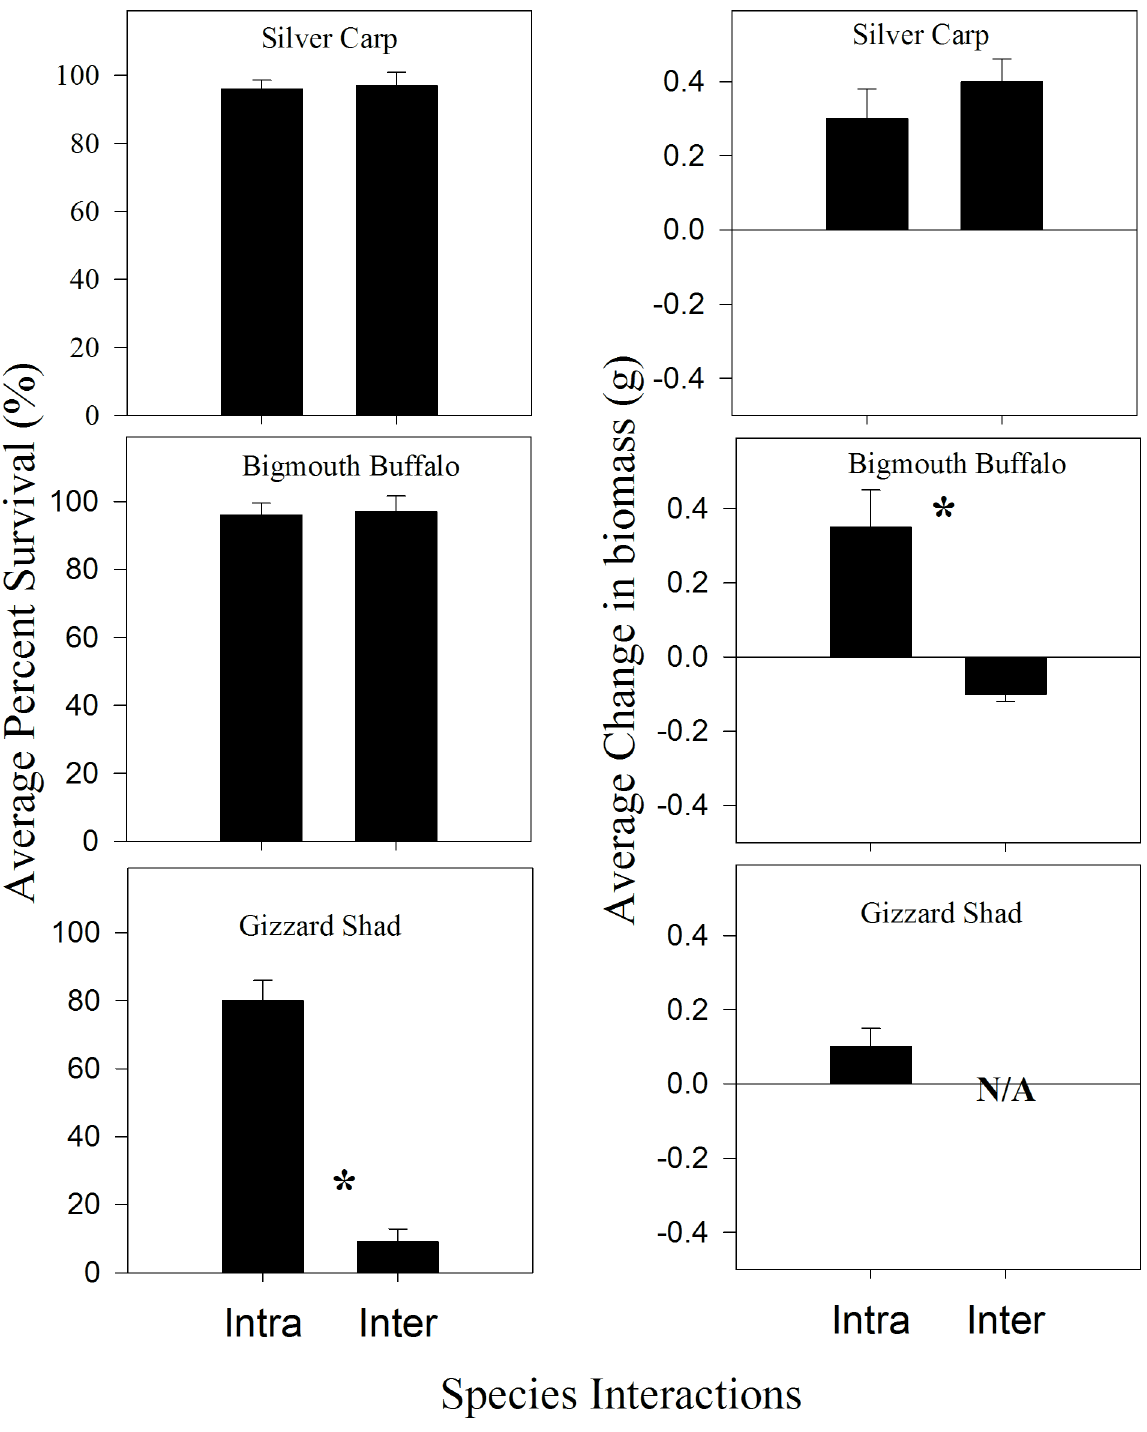
Fig 3. Mean survival and mean growth from both interspecific interaction experiments. Silver Carp * Gizzard Shad [N = 25], and Silver Carp * Bigmouth Buffalo [N = 26]) and intraspecific interactionexperiments (Silver Carp * SilverCarp [N = 25], Gizzard Shad * Gizzard Shad [N = 25], and Bigmouth Buffalo * Bigmouth Buffalo [N = 25]). BecauseGizzard Shad survival was low, Gizzard Shad growth within the interspecific group was not evaluated(N/A = too few samplesto evaluate growth. * Denotes treatments were statisticallydifferent, P < 0.05. Error bars represent standard